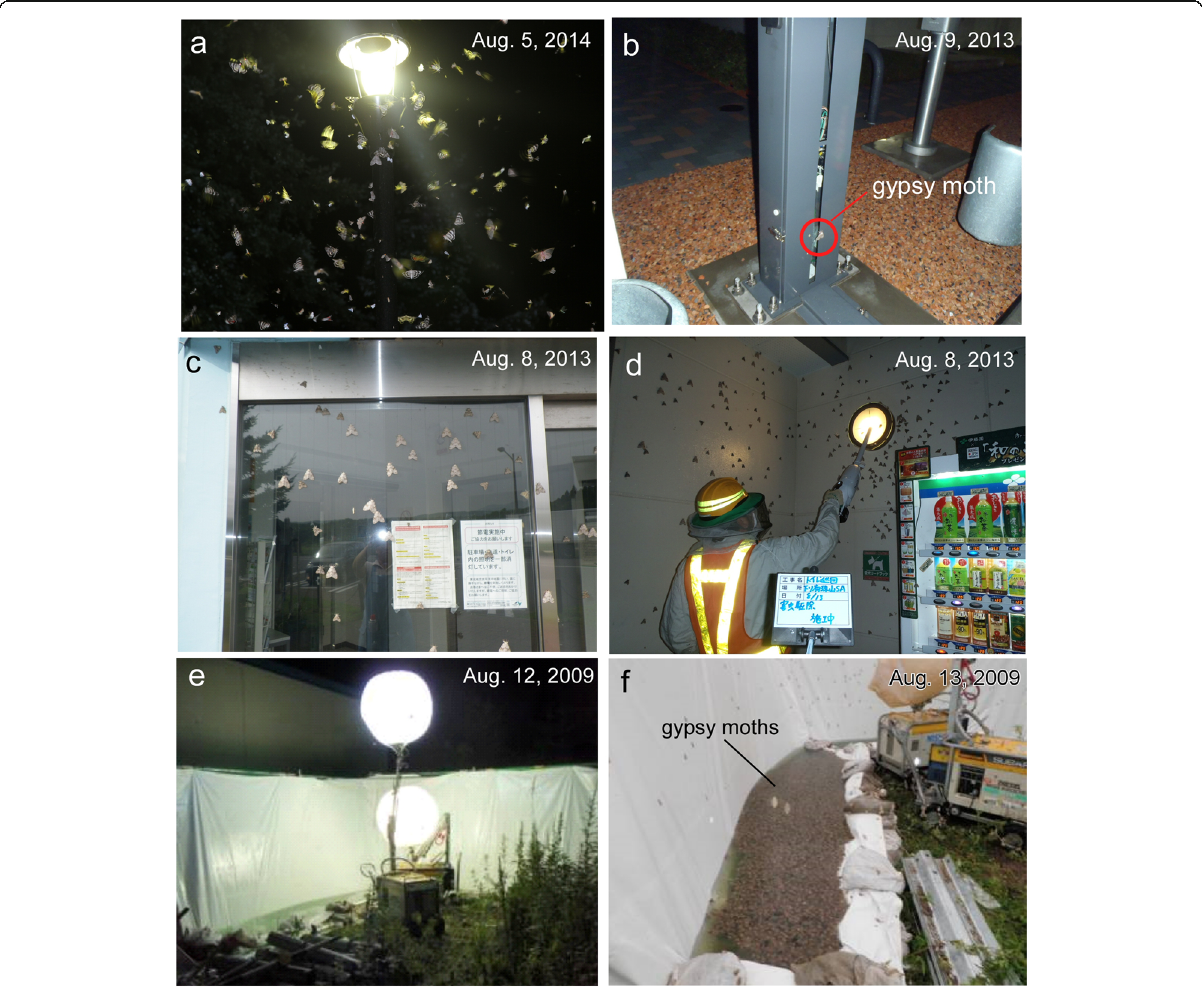
Fig. 2 Outbreaks of gypsy moths and sampling using light traps on expressways. Macromoths, such as gypsy moths and oak silkmoths, were lured to commercial lights in August ( a ), which coincided with the peak time of tourism. Errors occasionally occur in the Electronic Toll Collection (ETC) System due to sensor jamming by moths ( b ). Photograph taken at the Kuromatsunai Interchange showing female gypsy moths aggregated on the window of a shop ( c ). Another photograph taken at the Motowanishi Parking Area showing the manpower needed to remove gypsy moths on the walls of toilet rooms ( d ). A high-power balloon light set in the back area of the Ikeda Interchange trapped more than 20,000 gypsy moths in only one night during the outbreak in 2009 in Tokachi district ( e , f ). See Fig. 1a for locations of ( c )-( e ). The photograph ( a ) taken at the base of Mt. Daisetsu in central Hokkaido was courtesy of Dr. H.J.